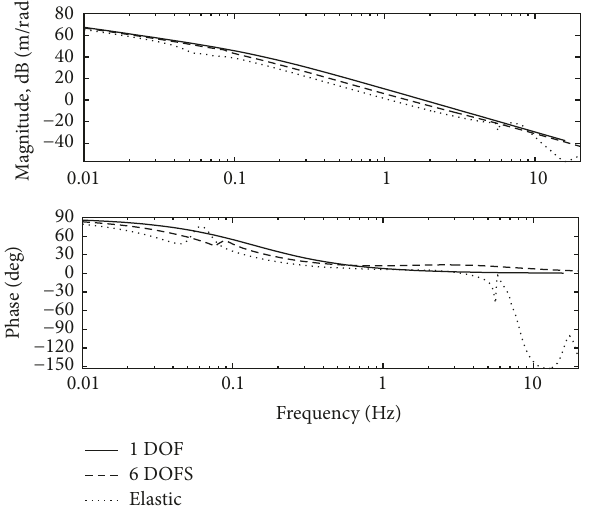
Figure 15: Active pilot models obtained using machine dynamics shown in Figure 14.